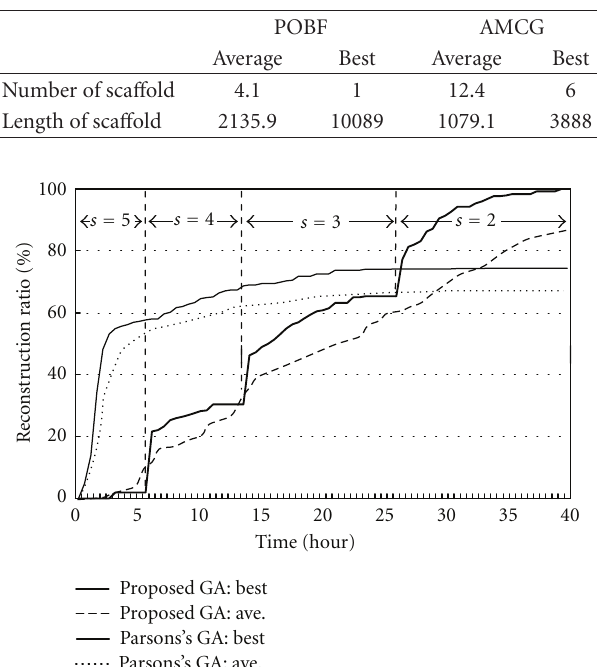
Table 4: Results about sca ff olds.